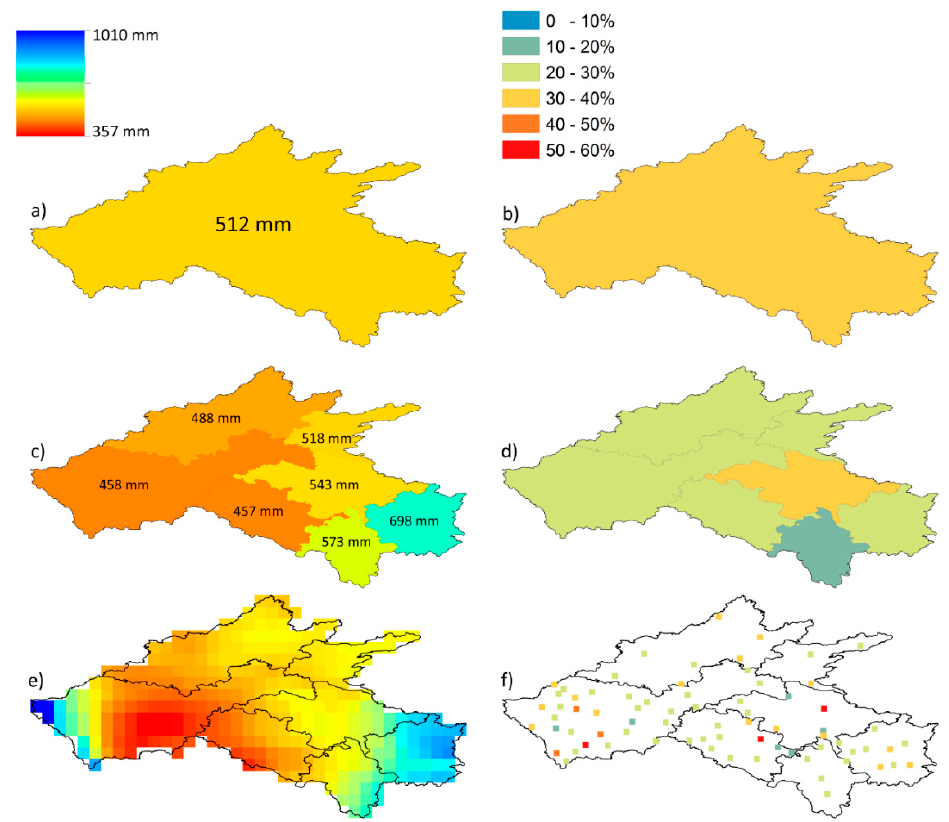
Figure 6. Period mean annual sum precipitation (1981–2010) according to different spatial aggregations: fully lumped ( a ), semi-lumped ( c ), and distributed ( e ). The % of non-zero AHCCD events outside the ensemble range when using different spatial aggregation schemes: fully lumped ( b ), semi-lumped ( d ), and distributed ( f ).